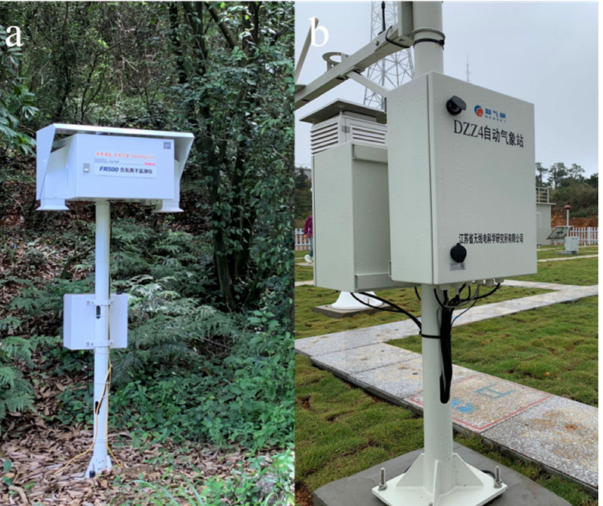
Figure 2. Meteorological observation system, including; ( a ) FR500 negative oxygen ion monitor, and ( b ) DZZ4 automatic meteorological